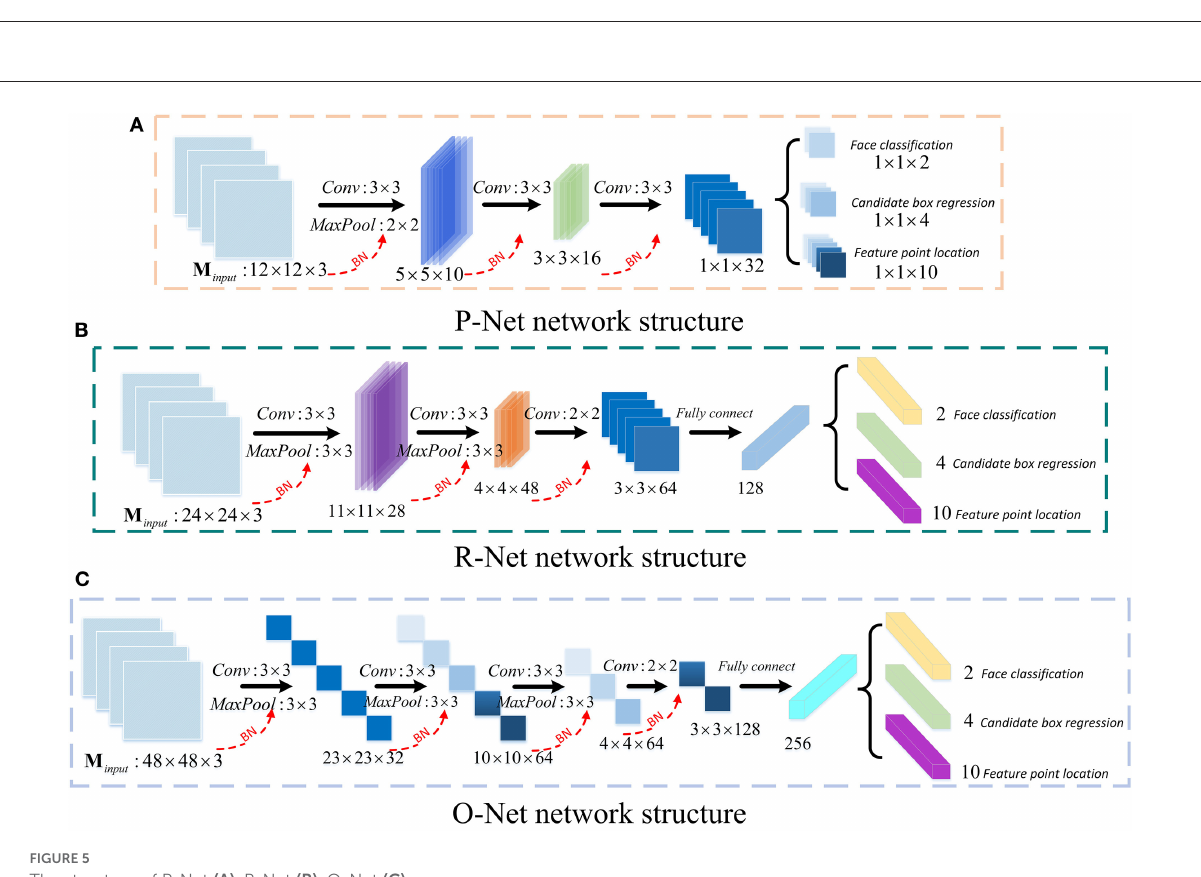
FIGURE5 The structure of P-Net (A) , R-Net (B) , O-Net (C)